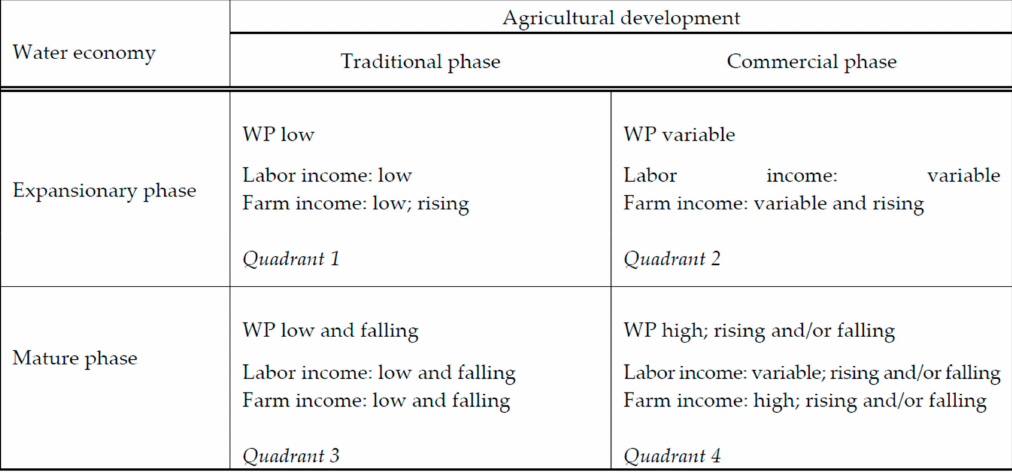
Figure 5. Conceptual framework the relationship between irrigation development status and for level and changes in water productivity, farm wages, and farm income. WP = water